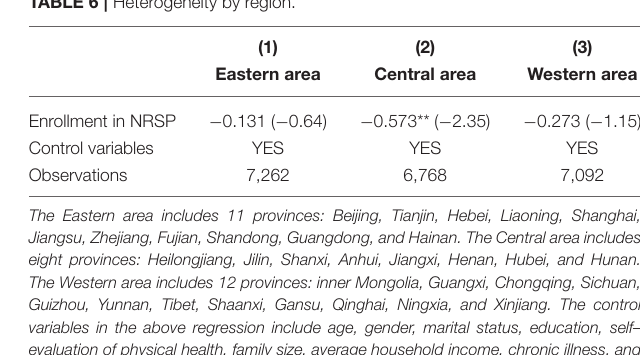
TABLE 6 | Heterogeneity by